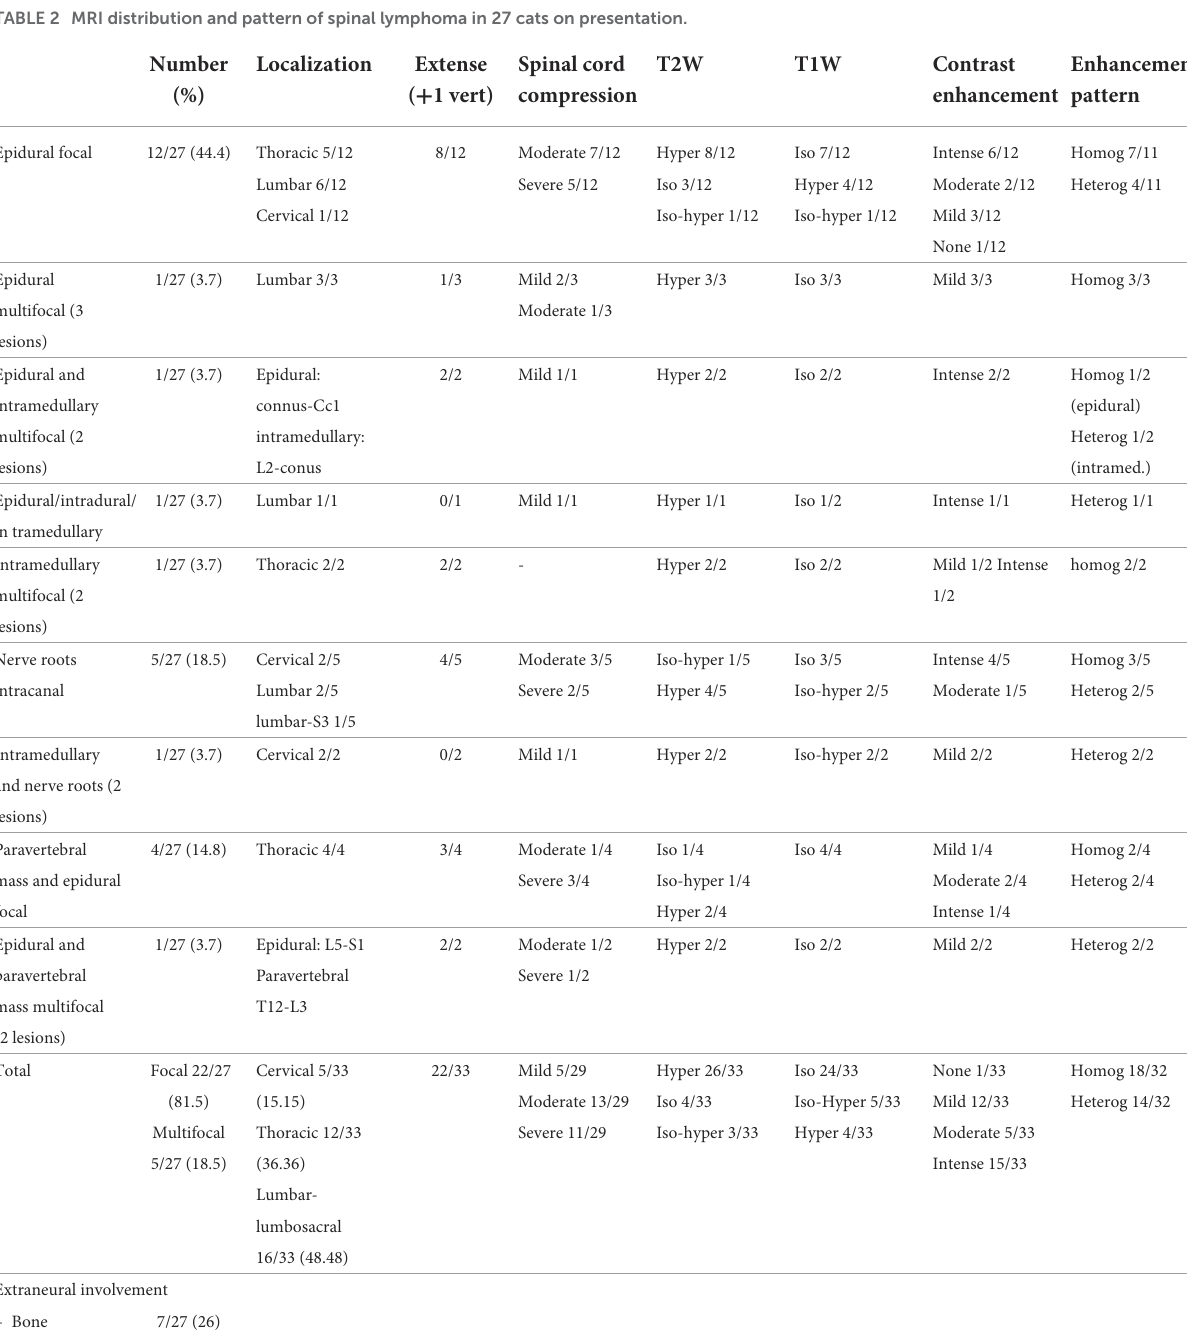
TABLE 2 MRI distribution and pattern of spinal lymphoma in 27 cats on presentation.